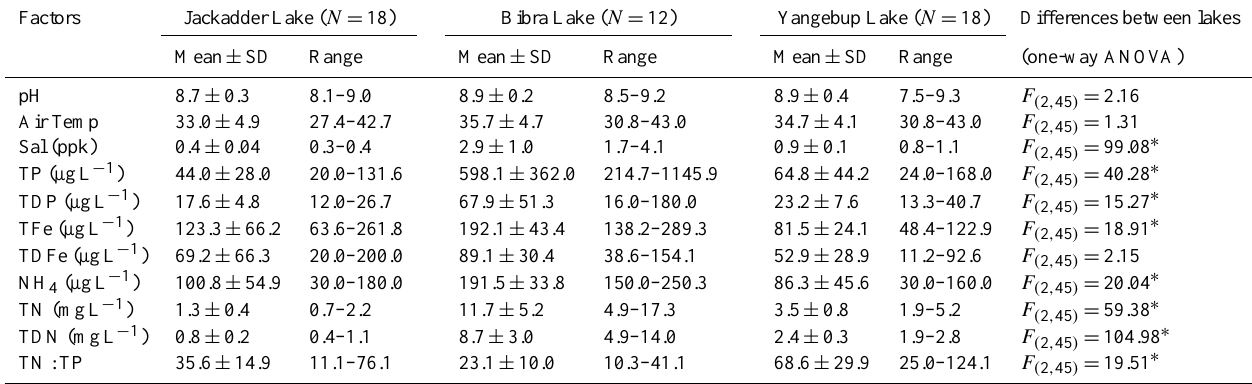
Table 1. Physical and chemical properties of the three lakes throughout the sample period (January–March 2010), including analysis of differences between lakes (one-way ANOVA).